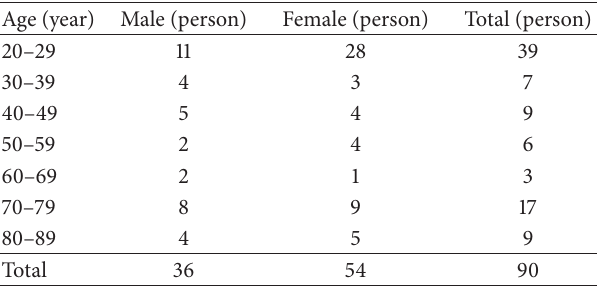
Table 2: Volunteer’s age and gender